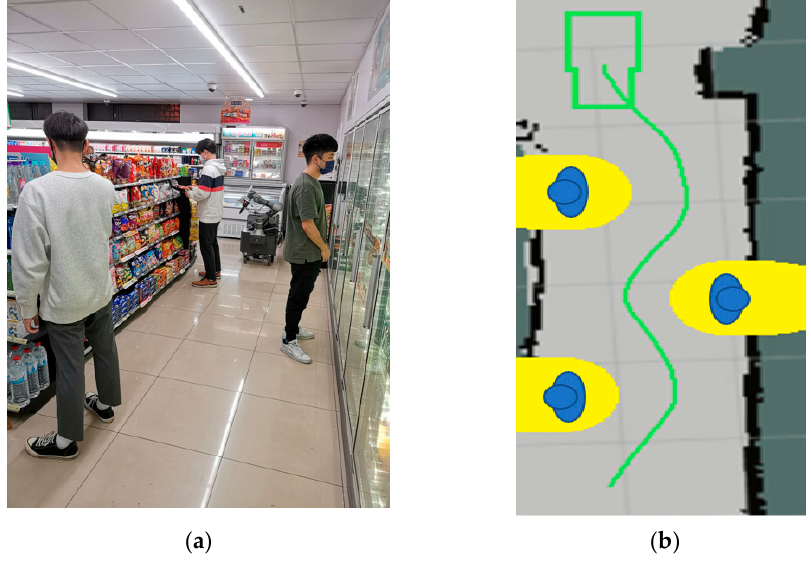
Figure 16. ( a ) The robot passed several customers and ( b ) the resultant collision-free path.